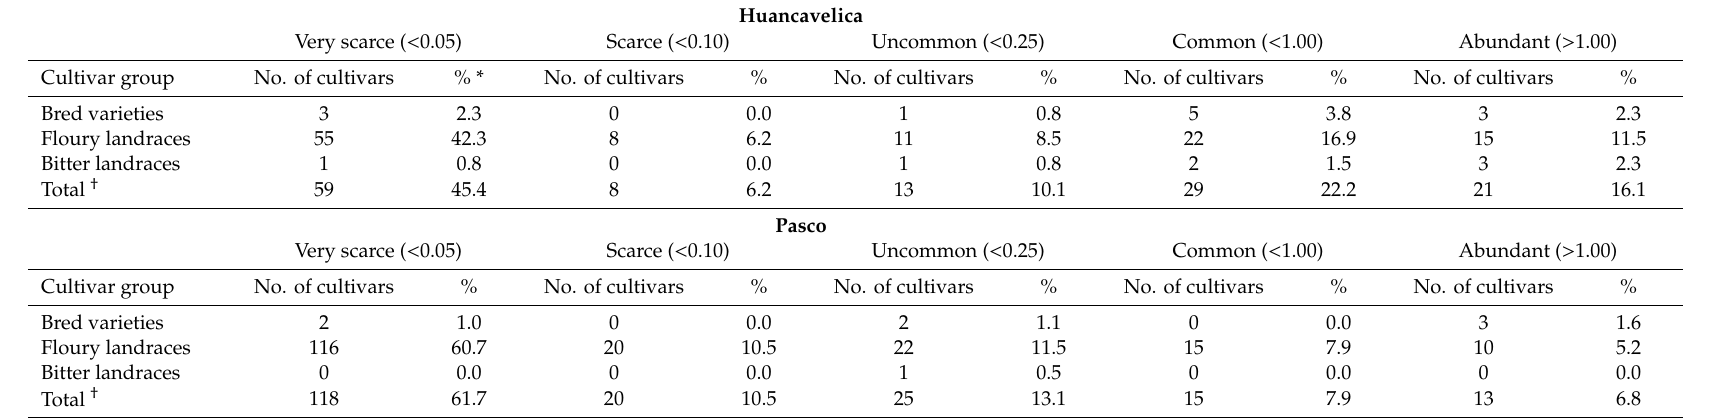
Table 6. Relative cultivar frequencies (RCF) or measure of relative abundance of cultivars by cultivar group and